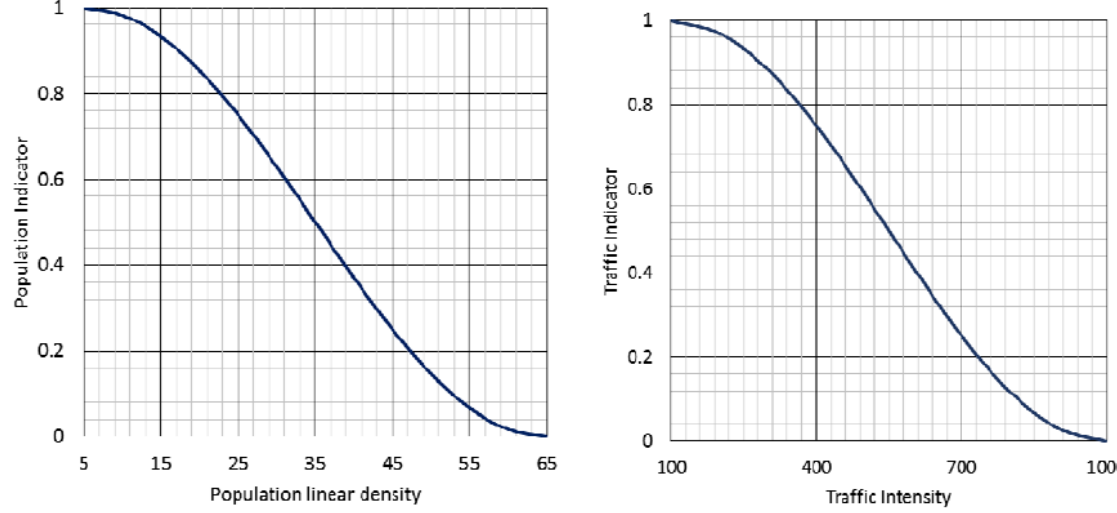
Figure 2: PI and TI values referred to the corresponding ranges of the case study